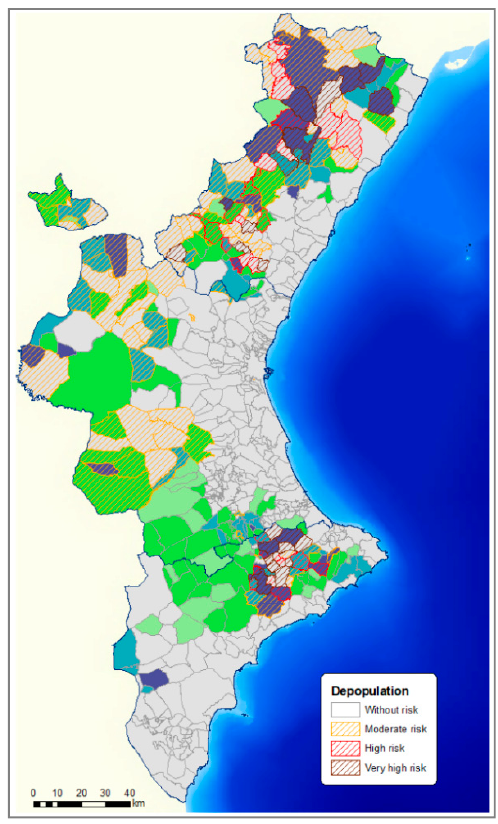
Figure 12. Relationship between municipalities with suitable land for swine sector development and municipalities with the risk of depopulation.